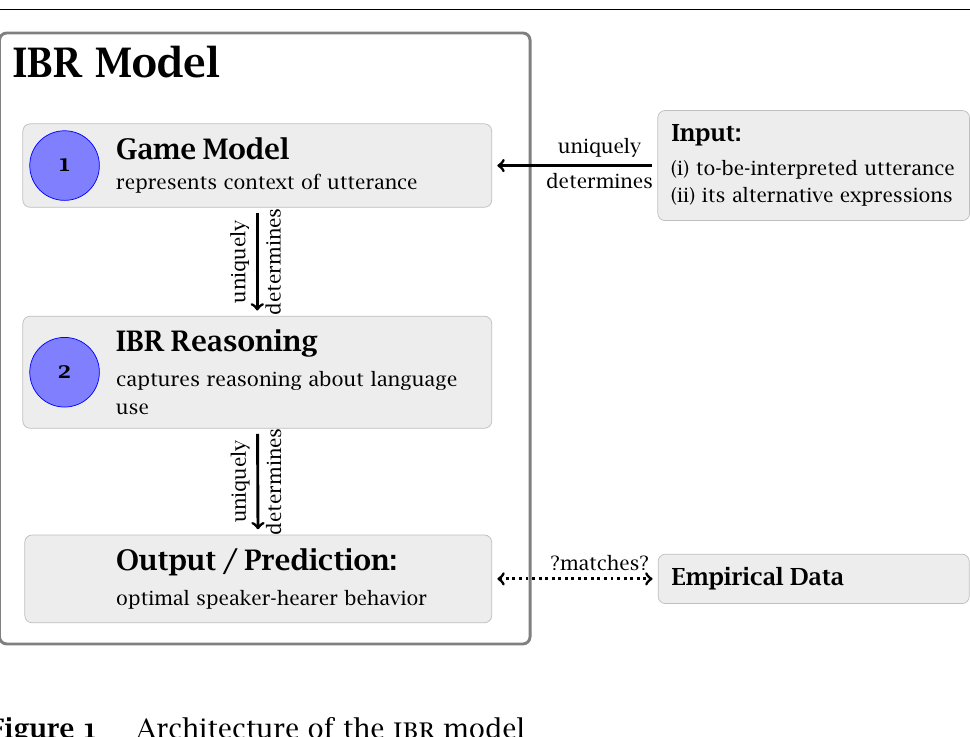
Figure 1 Architecture of the ibr